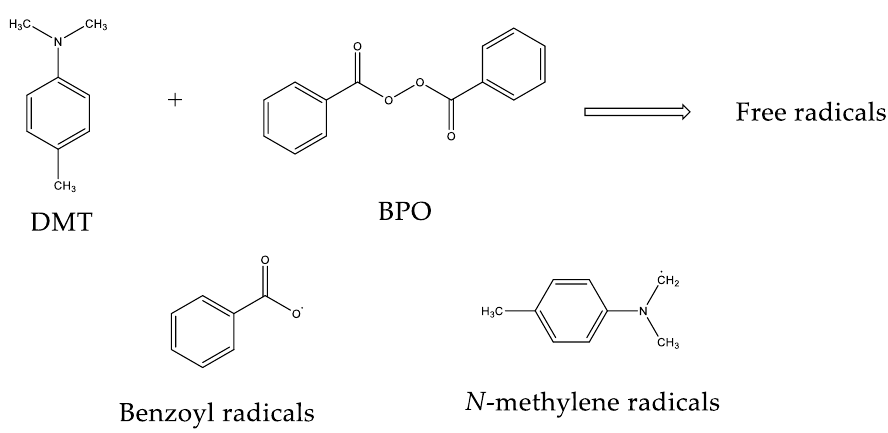
Figure 2. Free radicals generated during the initiation of polymerization process. DMT: N,N -dimethyl- p -toluidine; BPO: benzoyl peroxide.